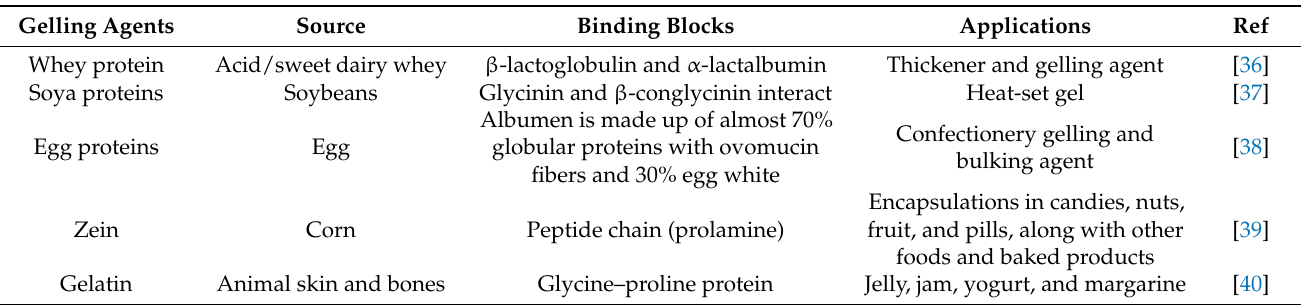
Table 2. Application of proteins as gelling